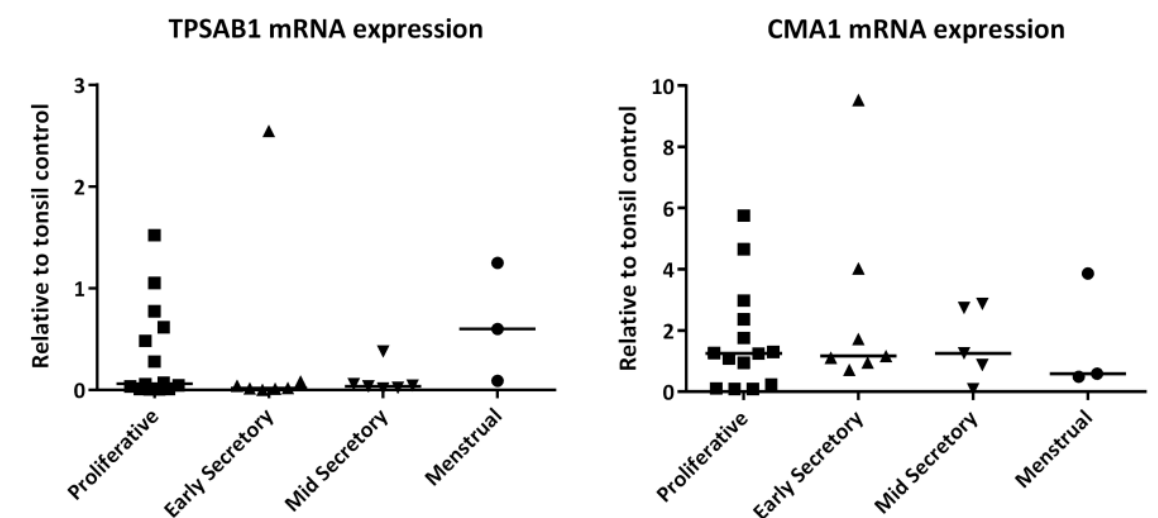
Figure 1. Messenger RNAs encoded by genes encoding mast cell proteases were not cycle stage dependent. ( A ) TPSAB1 mRNA and ( B ) CMA1 mRNA. Single dots represent different patient samples, and data are expressed as the median. Proliferative phase n=14, early secretory phase n=7, mid secretory phase n=6, and menstrual phase